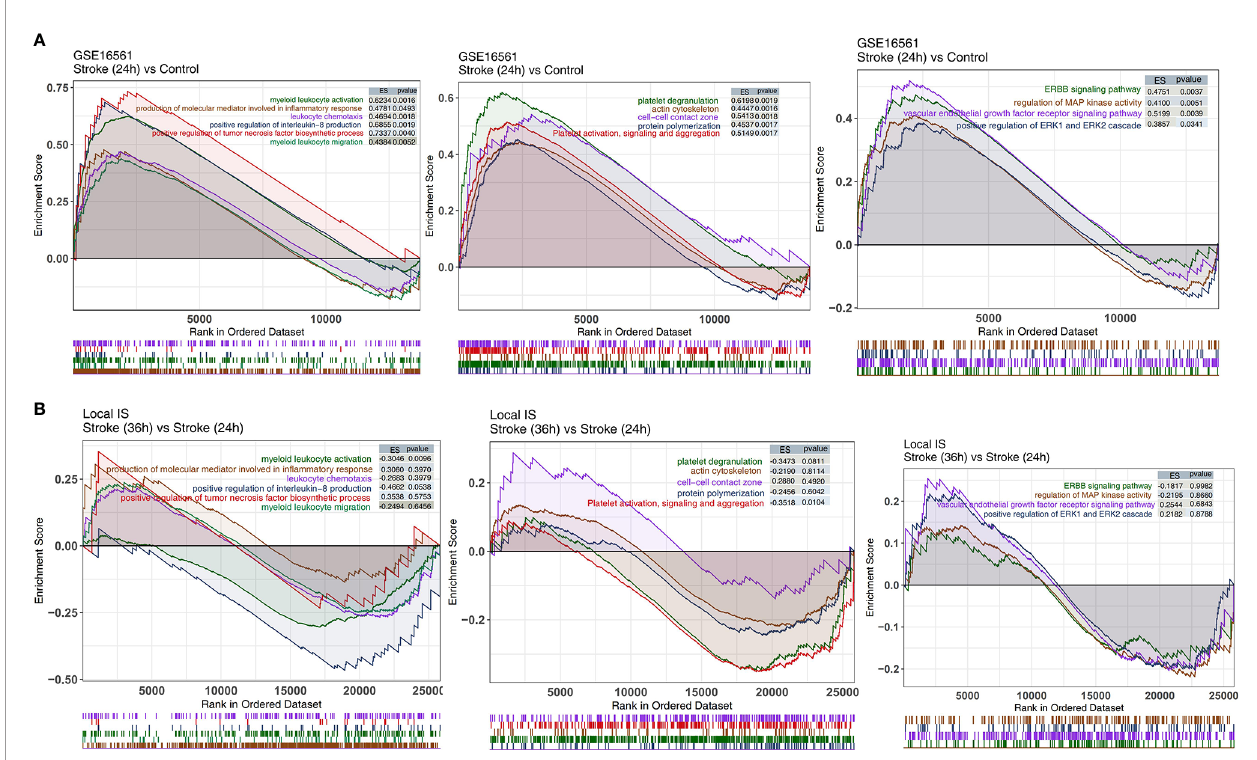
FIGURE 4 | The results of GSEA. (A) GSEA results for in fl ammation-related, platelet-related, and pathological pathways in GSE16561 compared between the IS- 24h and control groups. (B) GSEA results for in fl ammation-related, platelet-related, and pathological pathways in the Local-IS cohort compared between the IS-36h and IS-24h groups. All transcripts were ranked by the log2(fold change) between the IS-24h and control groups or IS-36h and IS-24h groups. Each run was performed with 1,000